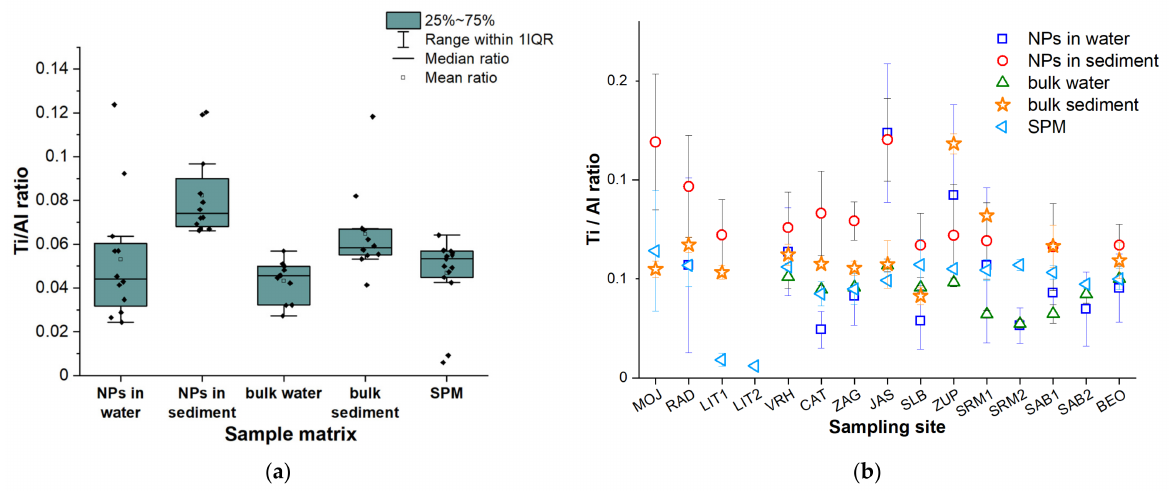
Figure 6. Ti/Al mass ratios determined in NPs in water, NPs in sediment extracts, bulk water, bulk sediment, and SPM: ( a ) Boxplots of Ti/Al values for each sample matrix determined by considering data from all sampling sites. Limits of the boxes and whiskers represent 25–75% percentiles and range within the 1st quartile, respectively, while the solid line and empty circle represent the median and mean ratios, respectively, observed within each sample matrix. ( b ) Ti/Al ratios of NPs in water, NPs in sediment extracts, bulk water, bulk sediment, and SPM at each sampling site. Each data represents the mean ± STD of N replicates (N = 4 for NPs in water, N = 6 for NPs in sediment samples, N = 4 for bulk water, N = 2 for bulk sediment and